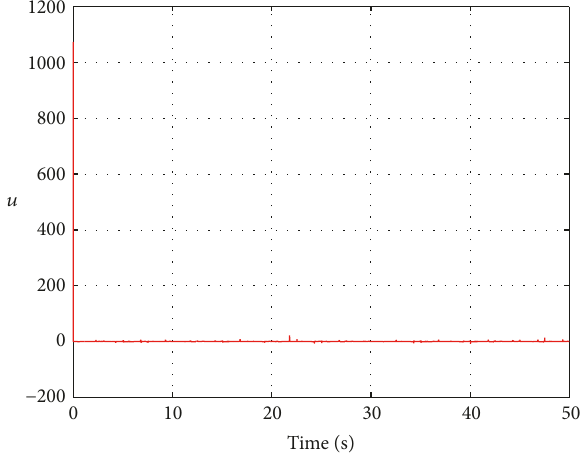
Figure 6: The trajectory of 𝑢